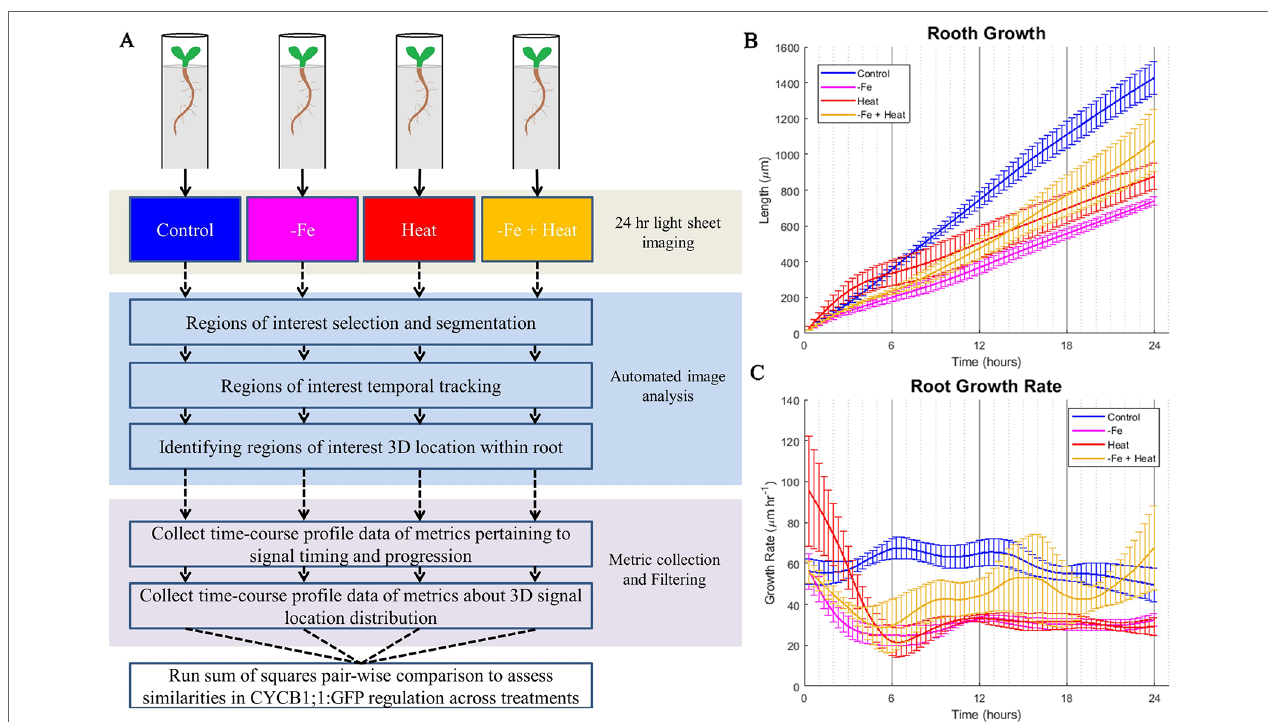
FIgURE 2 | Overall computational pipeline and root growth assays. (A) The overall flow of our experimental setup and computational approach. A. thaliana plants were grown in FEP tubes for 4 days and then treated to 1 of 4 of the same environmental conditions as the luciferase assay for 24 h while being imaged within the ZEISS Lightsheet Z.1 every 20 min. CYCB1;1:GFP, a proxy for entry into cell division, was visualized through a fluorescent channel. The images were then processed to segment, track, and locate CYCB1;1:GFP fluorescent regions of interest within the 3D locations of the root. Then, metrics were derived from the automated image analysis data to give temporal profiles of spatiotemporal CYCB1;1 data from fluorescent signals. These profiles were used to quantify similarities of cell division regulation across stress conditions. The total root growth during the course of the experiment (B) and the root growth rate (C) was recorded every 20 min over the 24 experiment for n = 3 to 4 biological